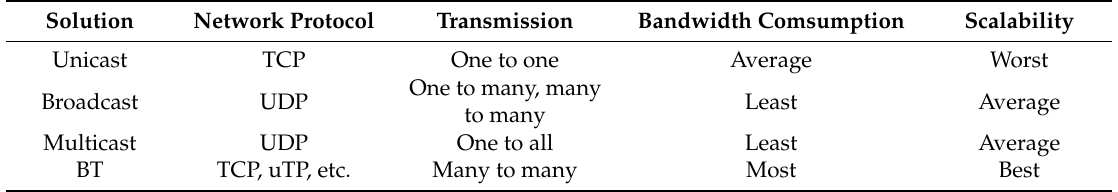
Table 1. Comparisons of existing solutions for system deployment. BT: BitTorrent, TCP: